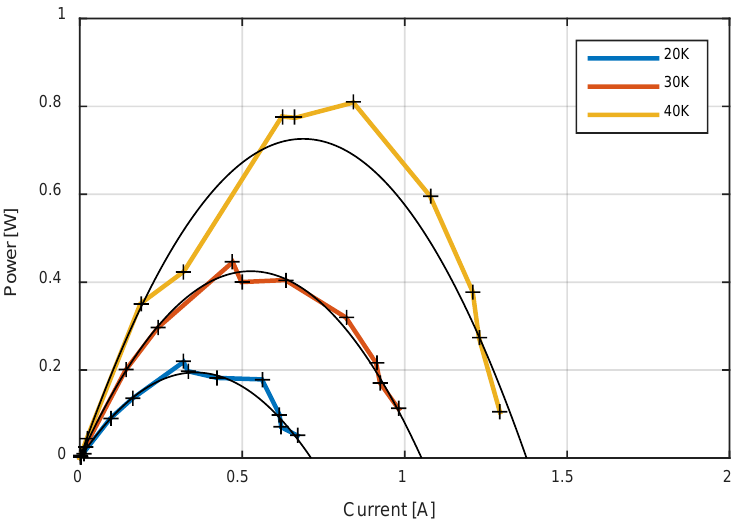
Figure 19. V–I experimental curves.